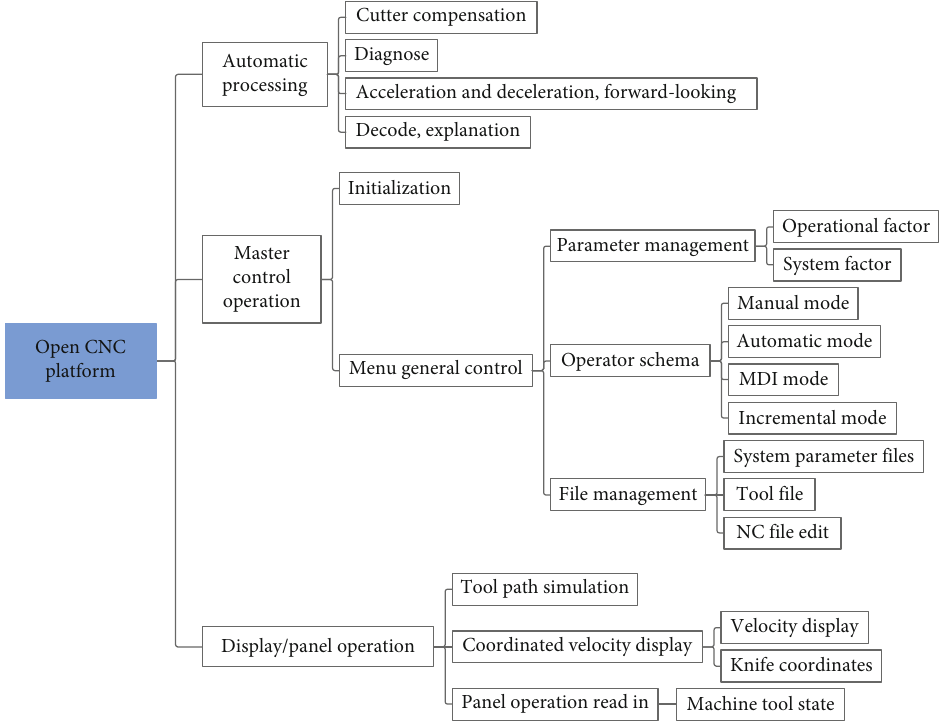
Figure 9: System function